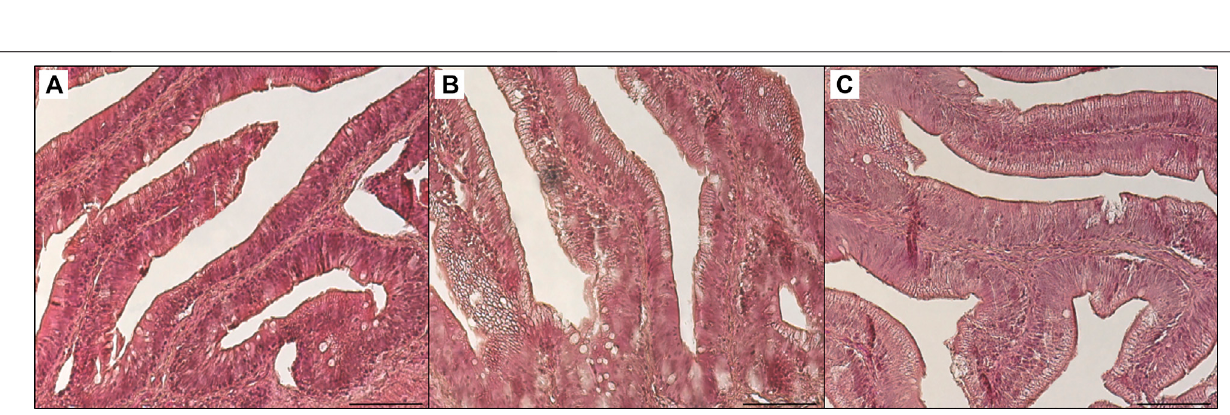
FIGURE 6 | Light microscopy of distal intestine portions of trout fed control diet (A) , poultry by-products meal diet (B) and insect meal diet (C) . Hematoxylin and eosin, scale bar = 100 μ m.